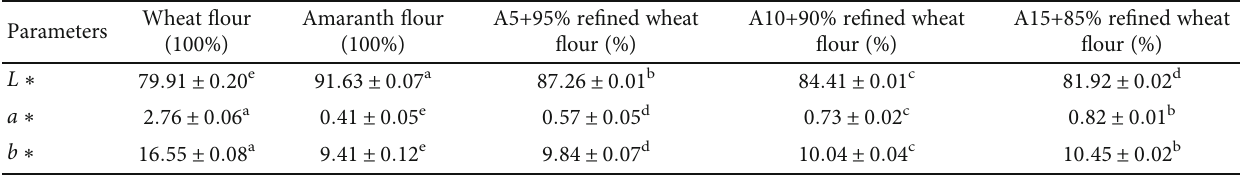
Table 4: Colour analysis of wheat fl our (WF), amaranth fl our (AF), and mixtures.